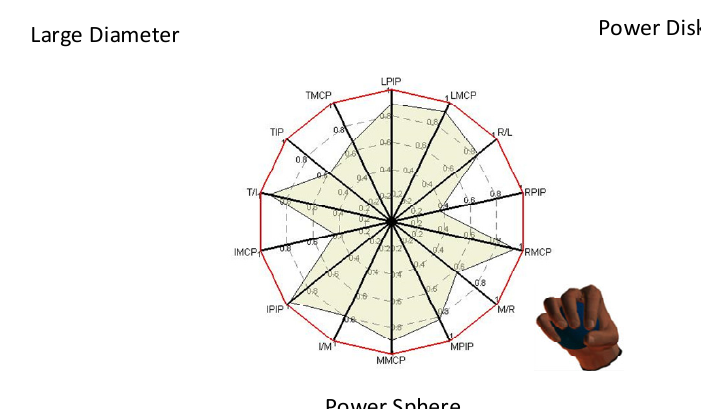
Table 4. R-squared coefficient of hand motion reconstructed by three postural synergy bases.